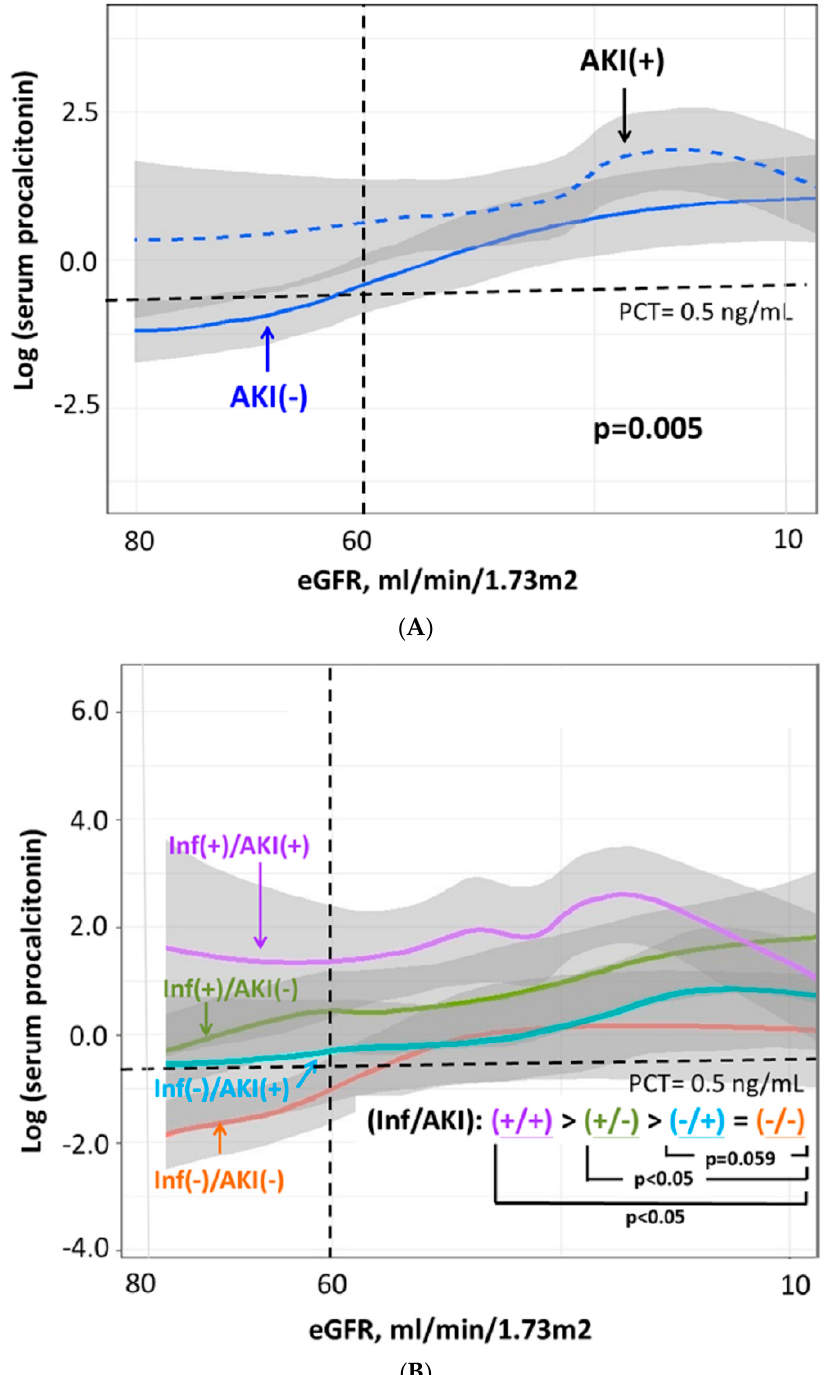
Figure 2. Comparisons of PCT levels among groups stratified by ( A ) AKI, and ( B ) AKI and infection. Abbreviations: AKI = acute kidney injury; eGFR = estimated glomerular filtration rate; inf = infection; PCT = procalcitonin.